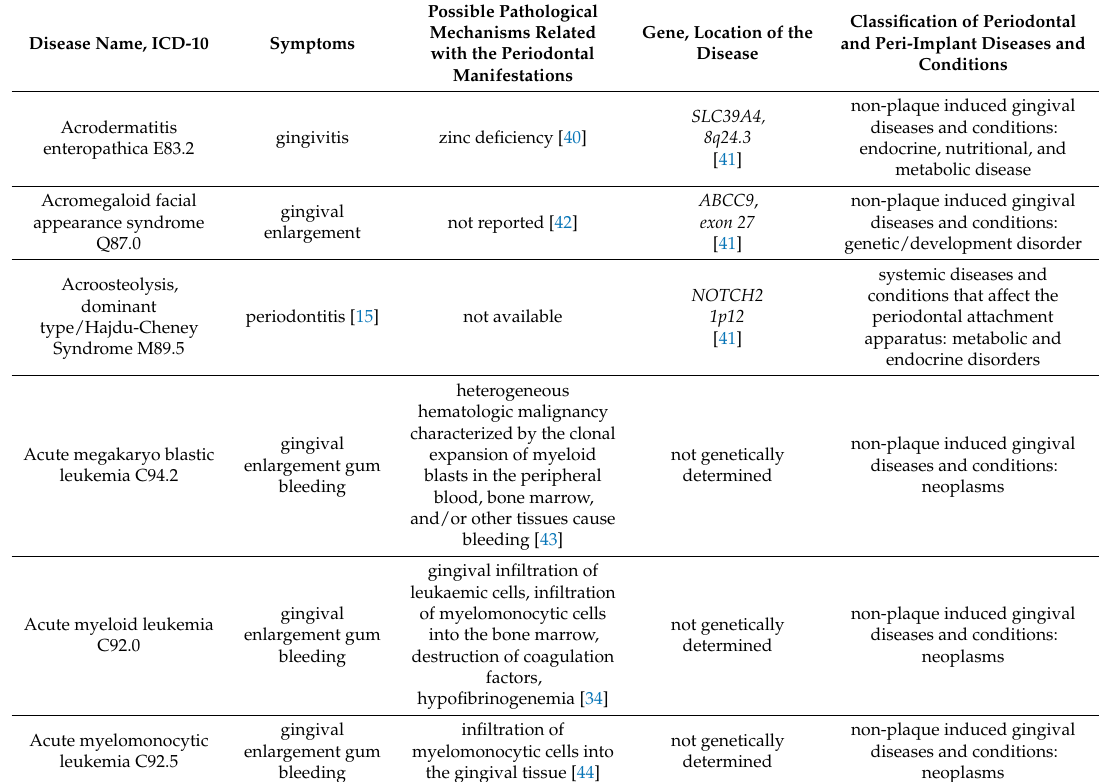
Table 1. Rare diseases with periodontal manifestations: symptoms, pathological mechanism, affected gene, and classification according the 2018 version of the Classification of Periodontal and Peri-Implant Diseases and